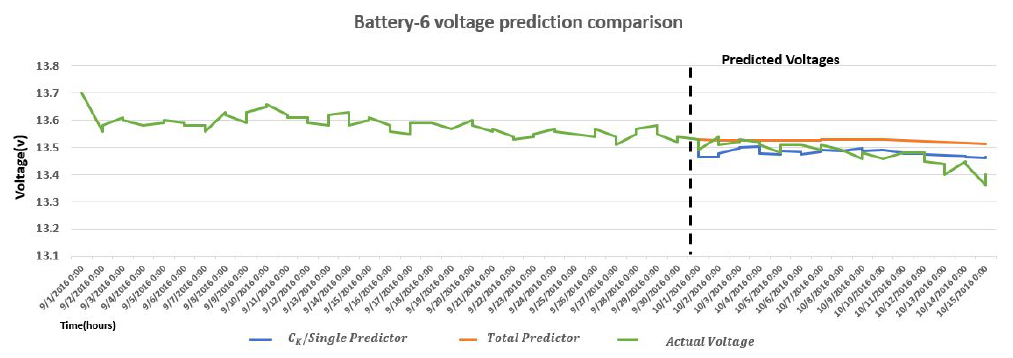
Figure 11. Comparison of measured and ARIMA forecasted voltage with Clustered (Single) predictor of Battery 6.